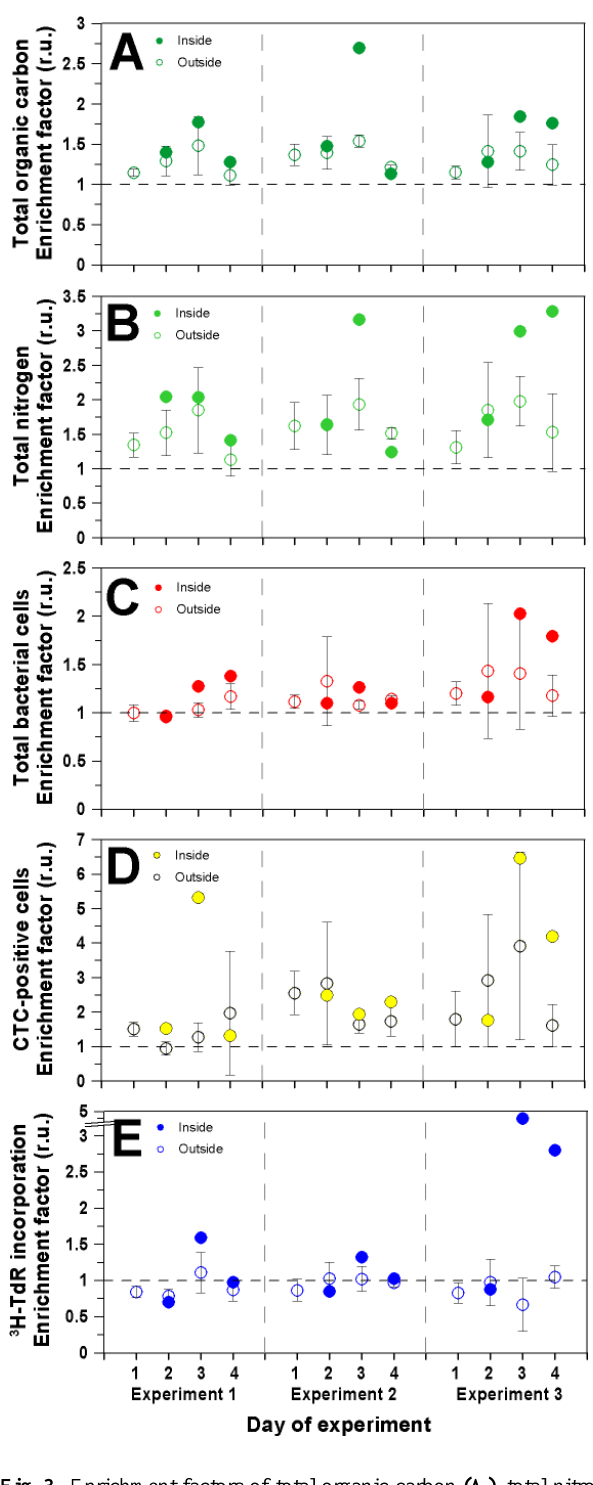
Fig. 3. Enrichment factors of total organic carbon (A) , total nitro- gen (B) , abundance of total bacterial cells (C) , and CTC-positive cells (D) as well as the incorporation of 3 H-thymidine (E) are given for the sea-surface microlayer inside (coloured circles) and outside (white circles) the mesocosms. Results of three experiments are shown. Error bars indicate standard deviation of three independent samples.